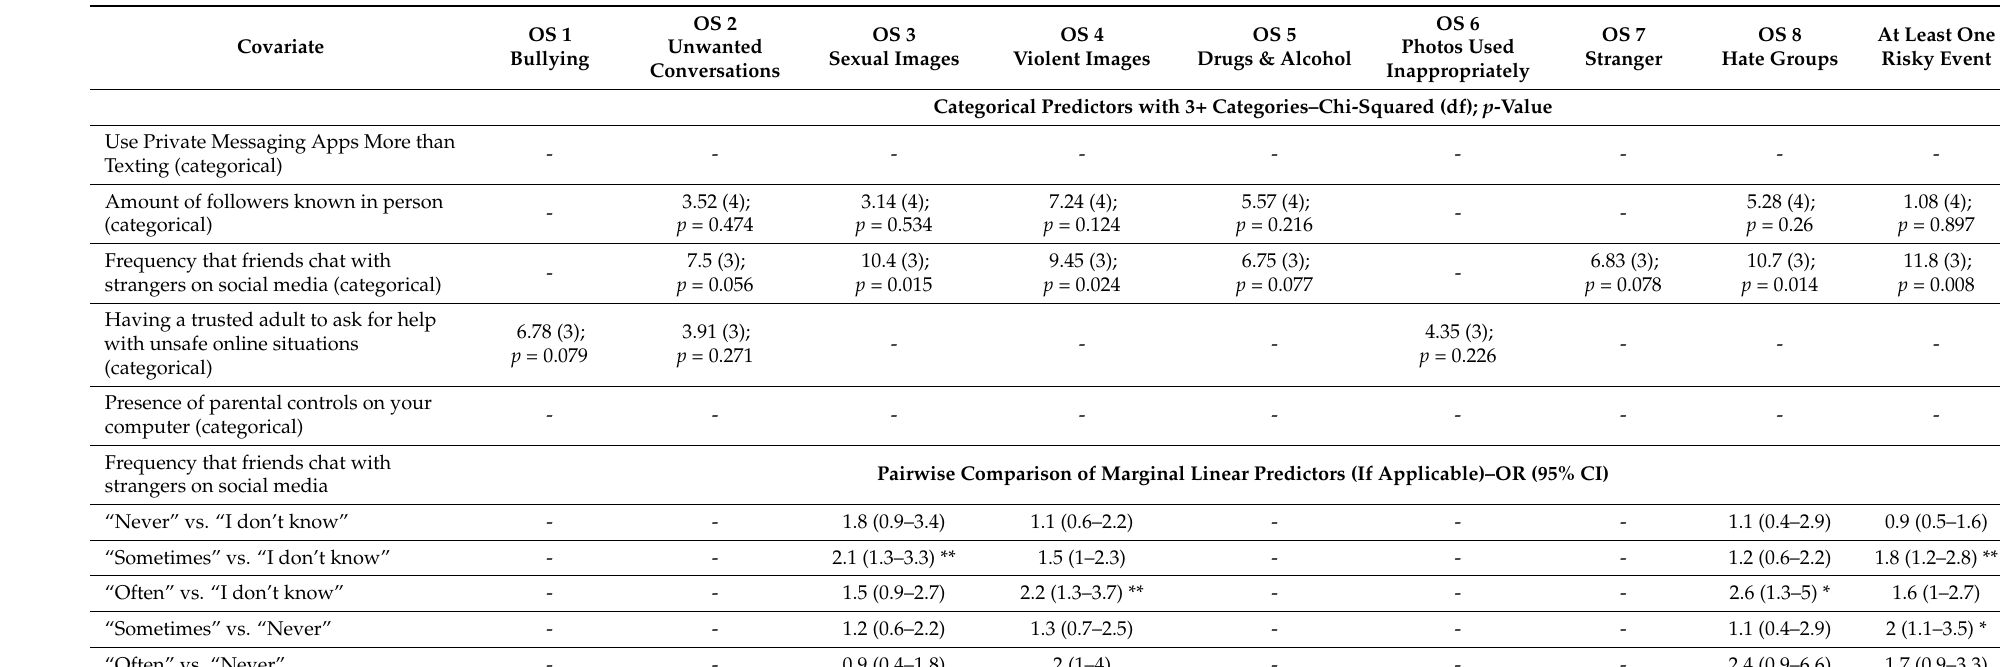
Table 4. Multiple Logistic Regression